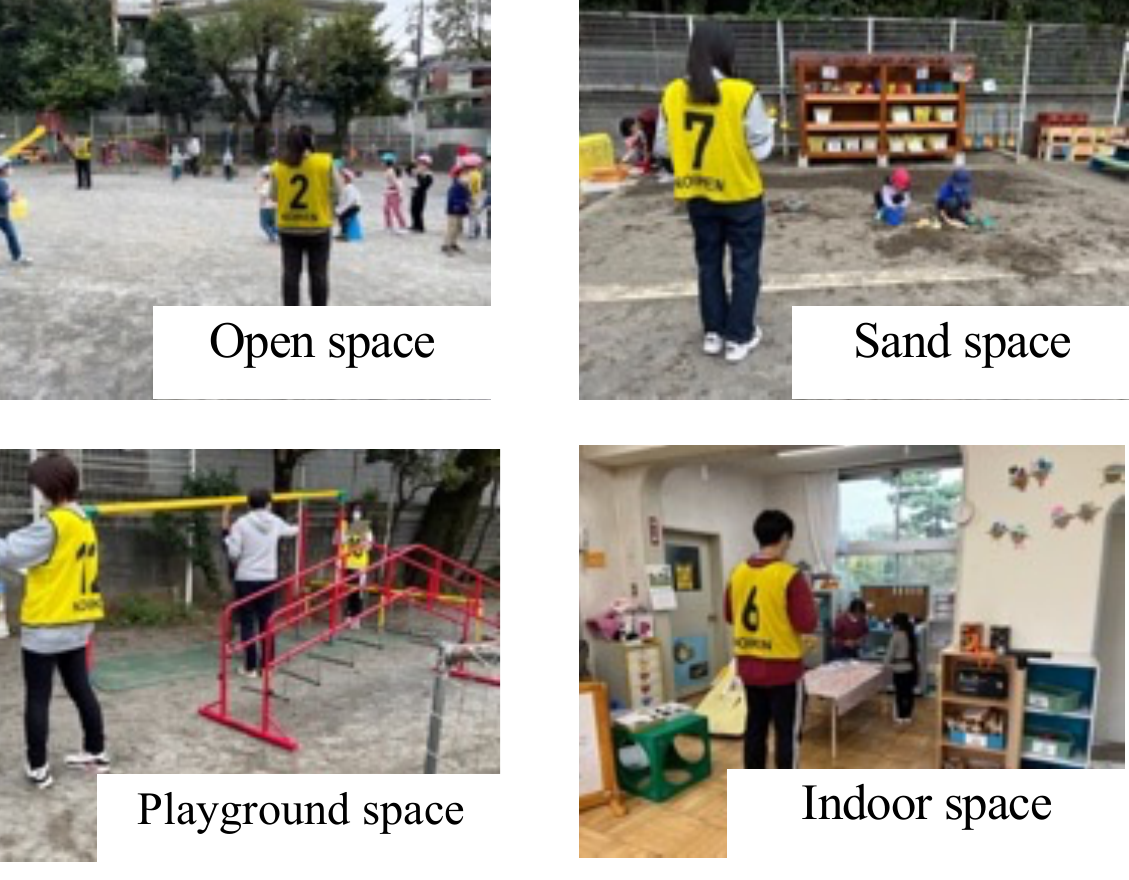
Figure 1. Observation of play in each area.